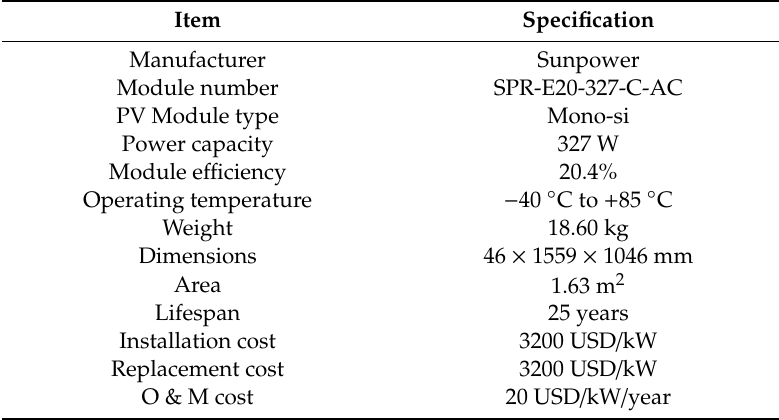
Table 4. Technical and economical specifications of the adopted photovoltaic module [30,31].